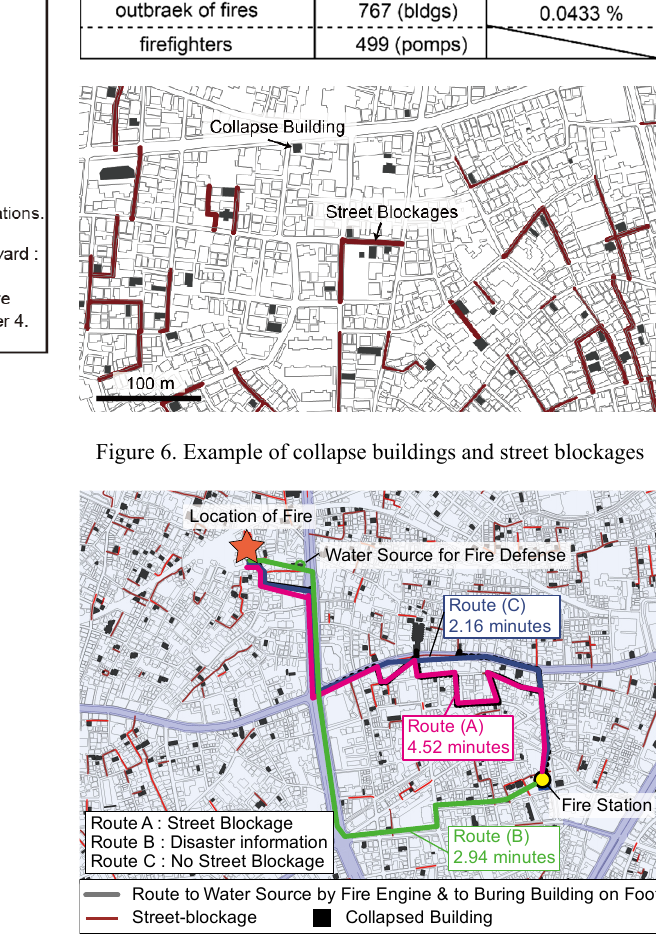
Figure 7. Example of the routes of